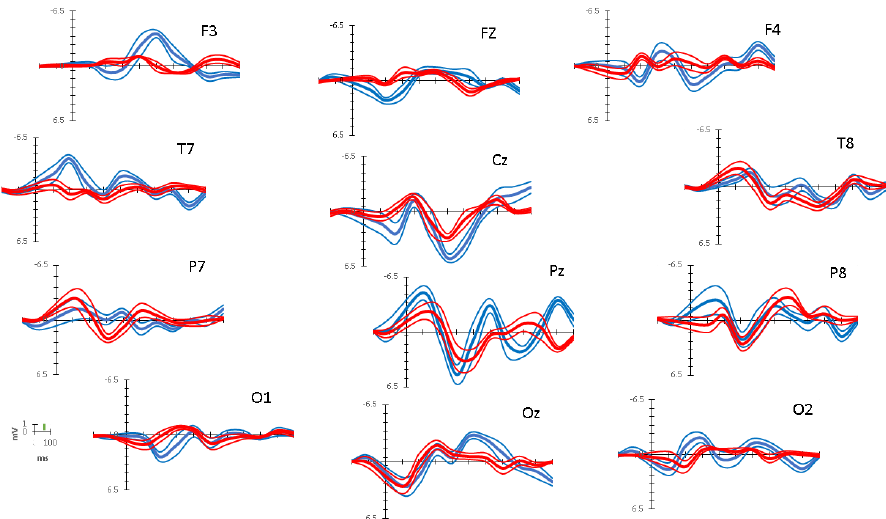
Figure 5. Average vincentized event-related potential (ERP) waveforms for targets (thick blue line) and distractors (thick red line) recorded over twelve electrode locations (F3, Fz, F4, Cz, T7, T8, P7, Pz, P8, O1, Oz, O2) for the epoch ranging from 200 ms prior to onset of each stimulus image to 1000 ms after the stimulus image. Standard errors are represented by thin lines. The microvolt value corresponding to the significance threshold is shown as a green line in scale against the y -axis in µV of observed ERP amplitude range at the bottom left legend.